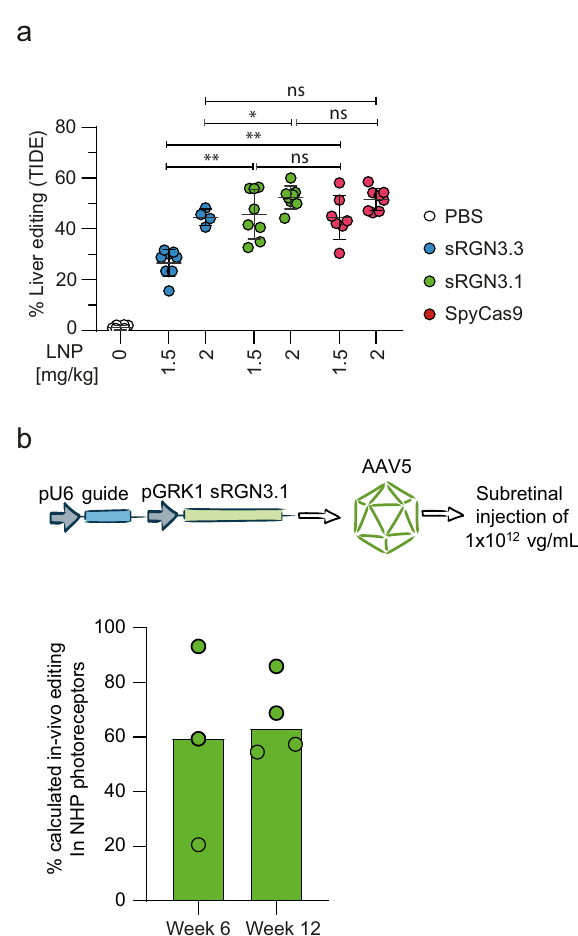
the source data fi